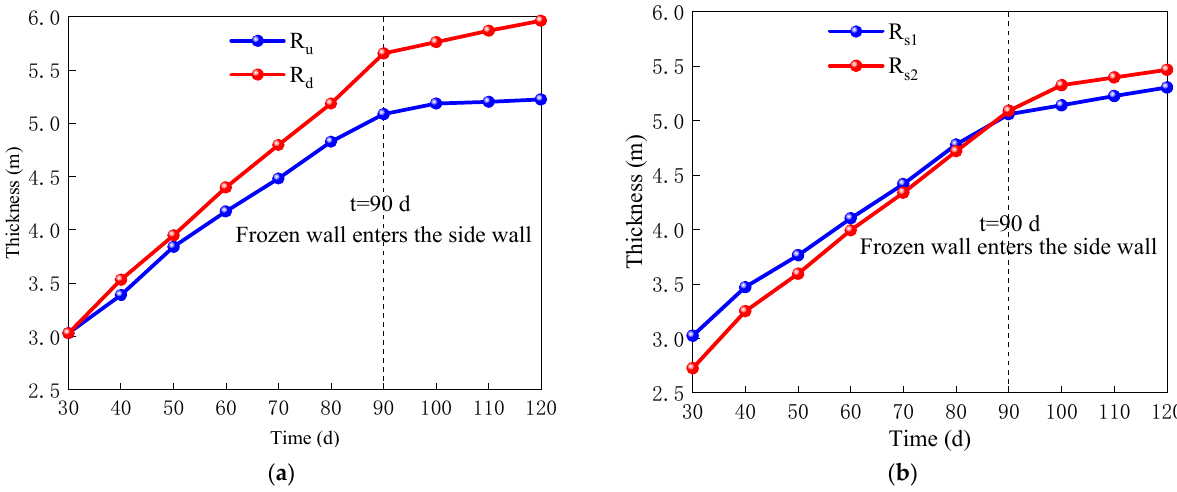
Figure 9. Effective frozen wall thickness of − 135 m fine sand layer. ( a ) Thickness of upstream and downstream; ( b ) thickness of flank.